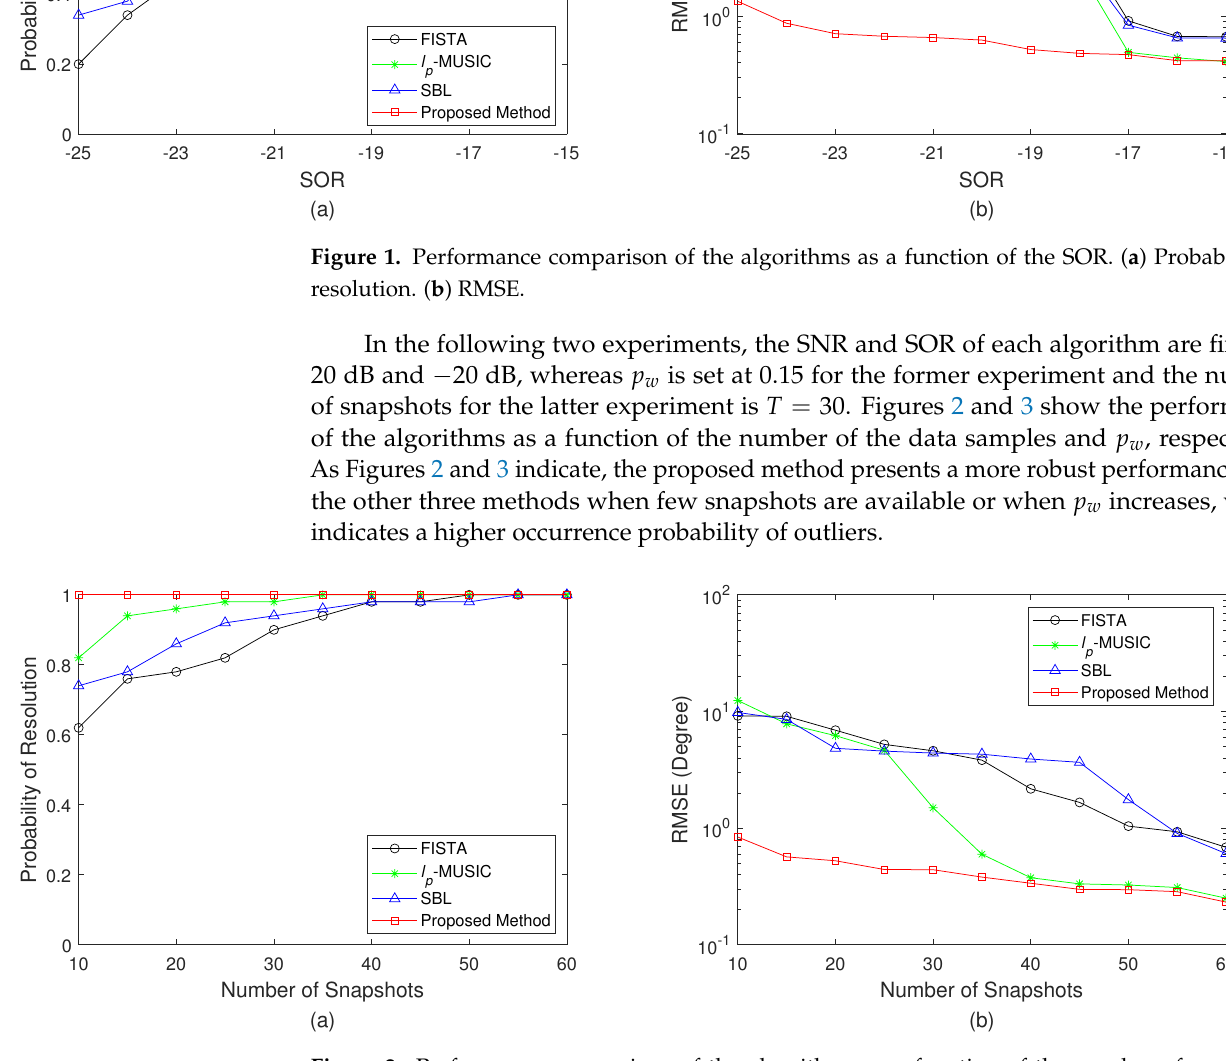
Figure 2. Performance comparison of the algorithms as a function of the number of snapshots. ( a ) Probability of resolution. ( b )